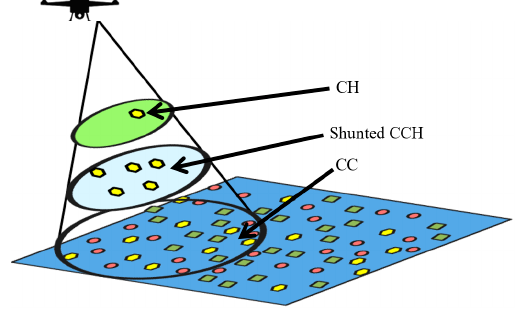
Figure 4. Dynamic clustering scheme.